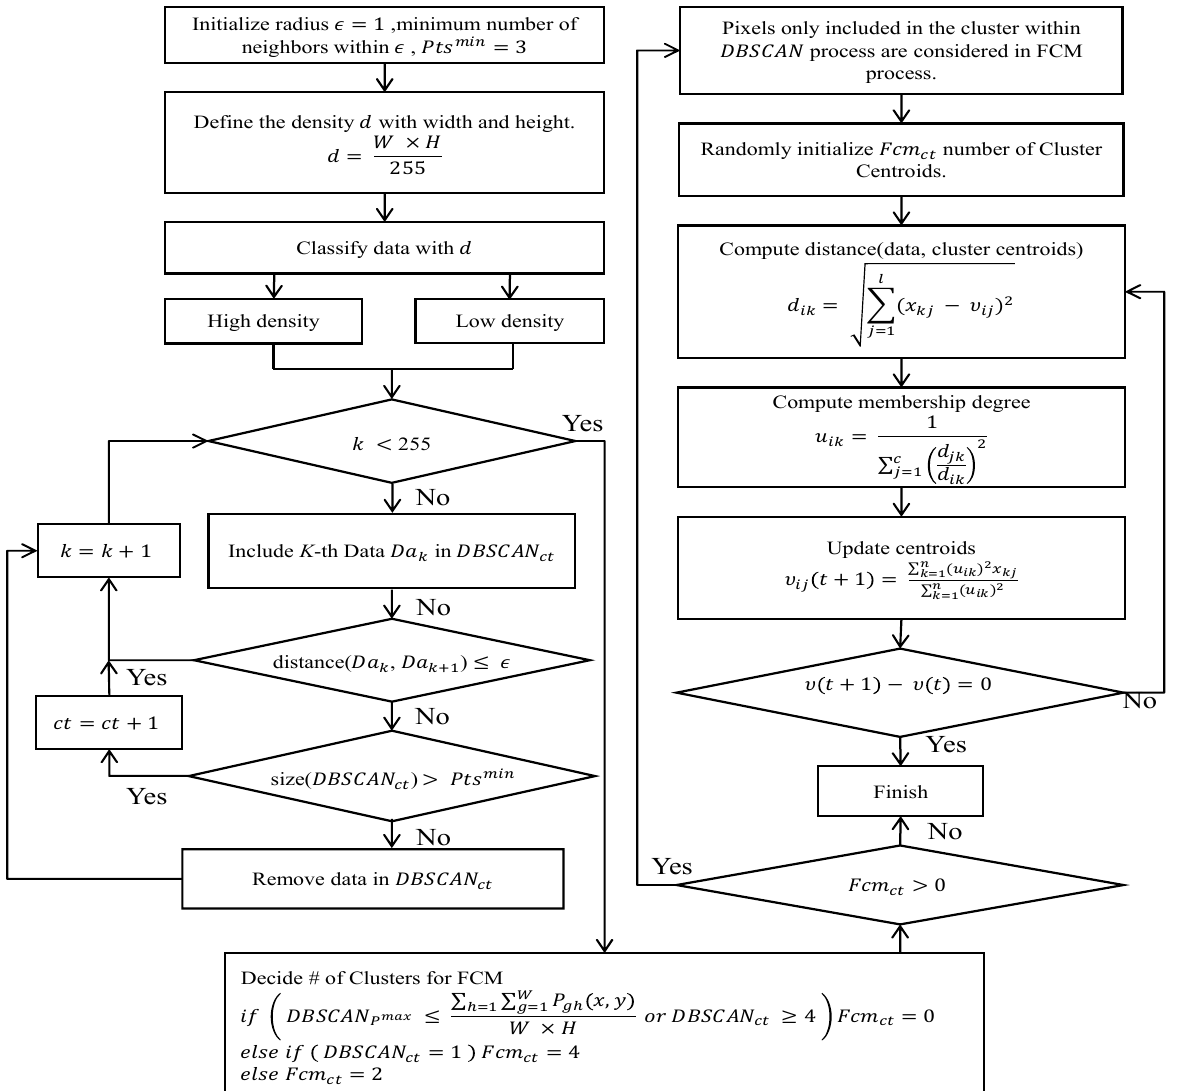
Figure 5. Overall clustering and quantization process.